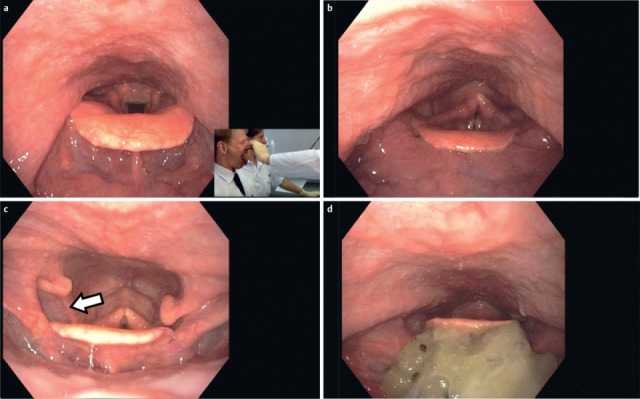
Position 1 – view over larynx and pharynx, optic window (oF) = level of the palatal arch: a – with the tongue stuck out, the valleculae can be directly seen; b – pharynx and larynx in phonation of “I”; c – the Valsalva maneuver shows the structures of the thyroid cartilage and pouch (arrow: muscle-free triangle of the thyrohyoid membrane); d – valleculae and base of tongue prepare the kiwi bolus.